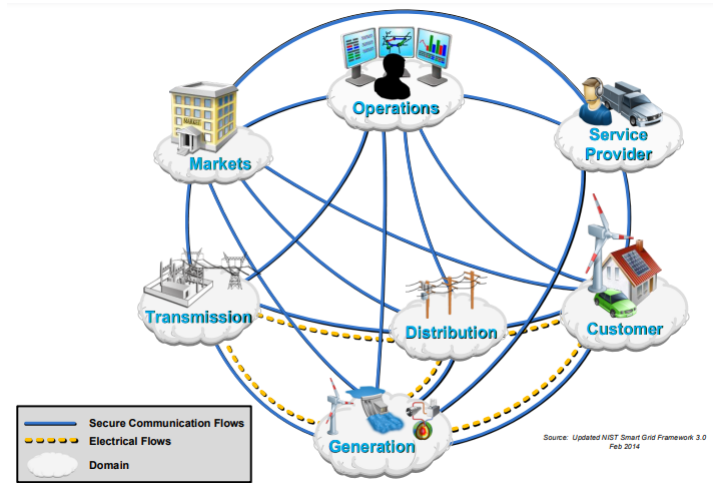
Figure 2. NIST conceptual domains [7].